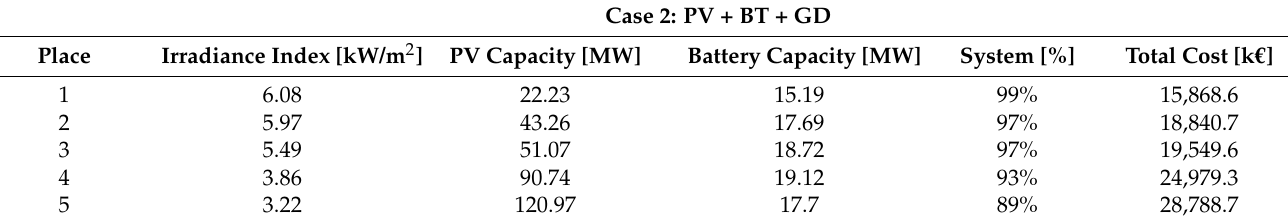
Table 3. Summary of total costs—second scenario.